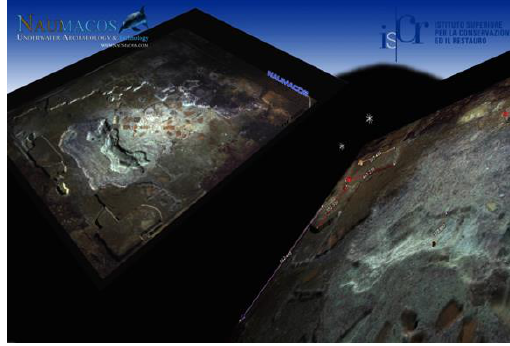
Fig. 5 - The opus sectile floor: 3D results (ISCR Archive)